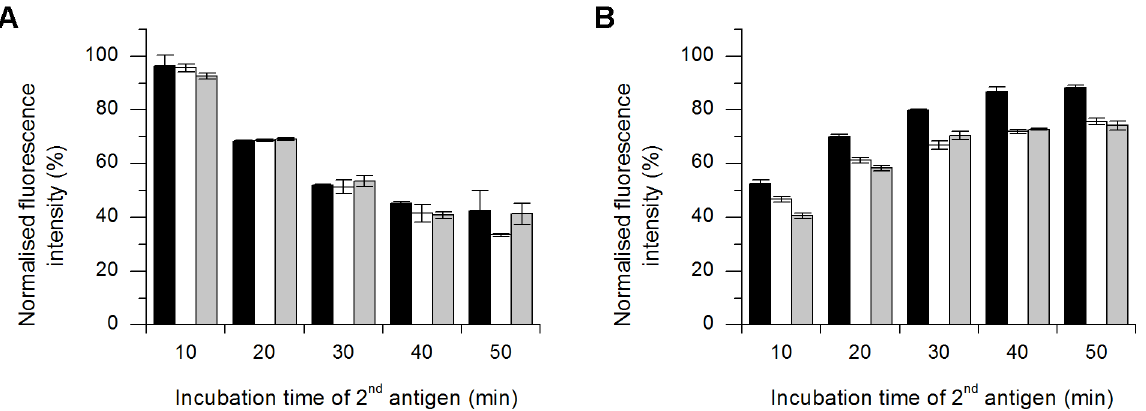
Fig 8. Time-dependent replacement of GFP-hCC with hCC and vice versa. PBS was exchanged for hCC ( A ) and for GFP-hCC ( B ) at 10-min intervals and each assay was carried out in triplicate (error bars represent standard deviations). The background was subtracted from mean values and the resulting fluorescence was normalised to the positive control and was plotted as a percentage. The assay was carried out three times (n = 1 – 3 indicated as black, white and grey